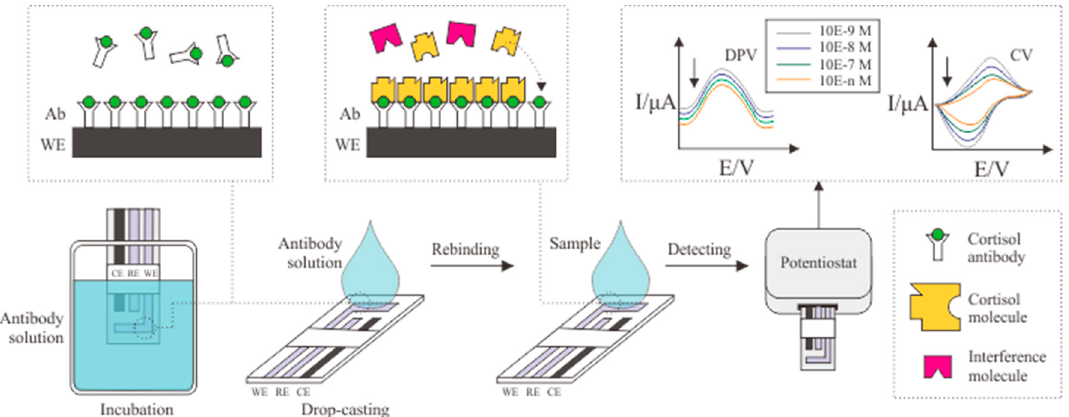
Figure 1. Schematic illustration of cortisol antibody immobilization in the electrode.